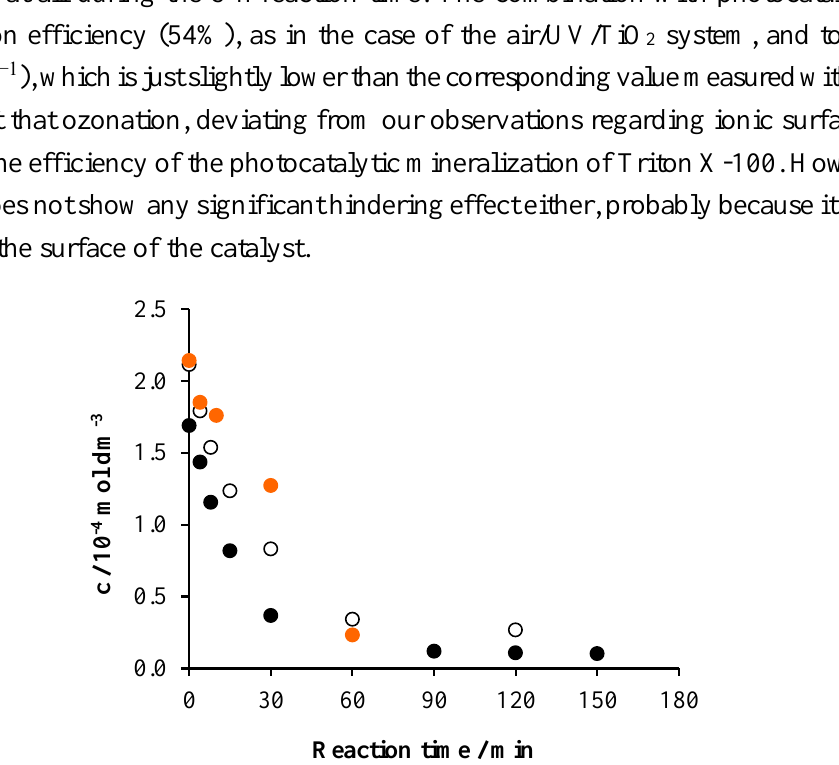
Figure 8. The change of the Triton X-100 concentration as a function of the reaction time under various conditions in the system containing 2 × 10 −4 mol·dm −3 Triton X-100 and